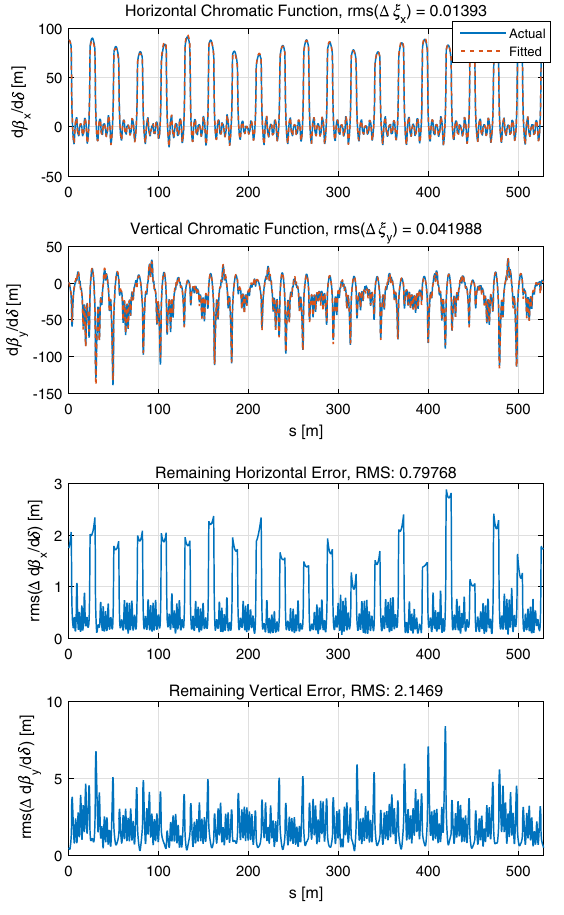
FIG. 6. The chromatic functions of one seed with sextupole circuit errors and the fitted model (top), and the RMS remaining error calculated from 10 error seeds (bottom).